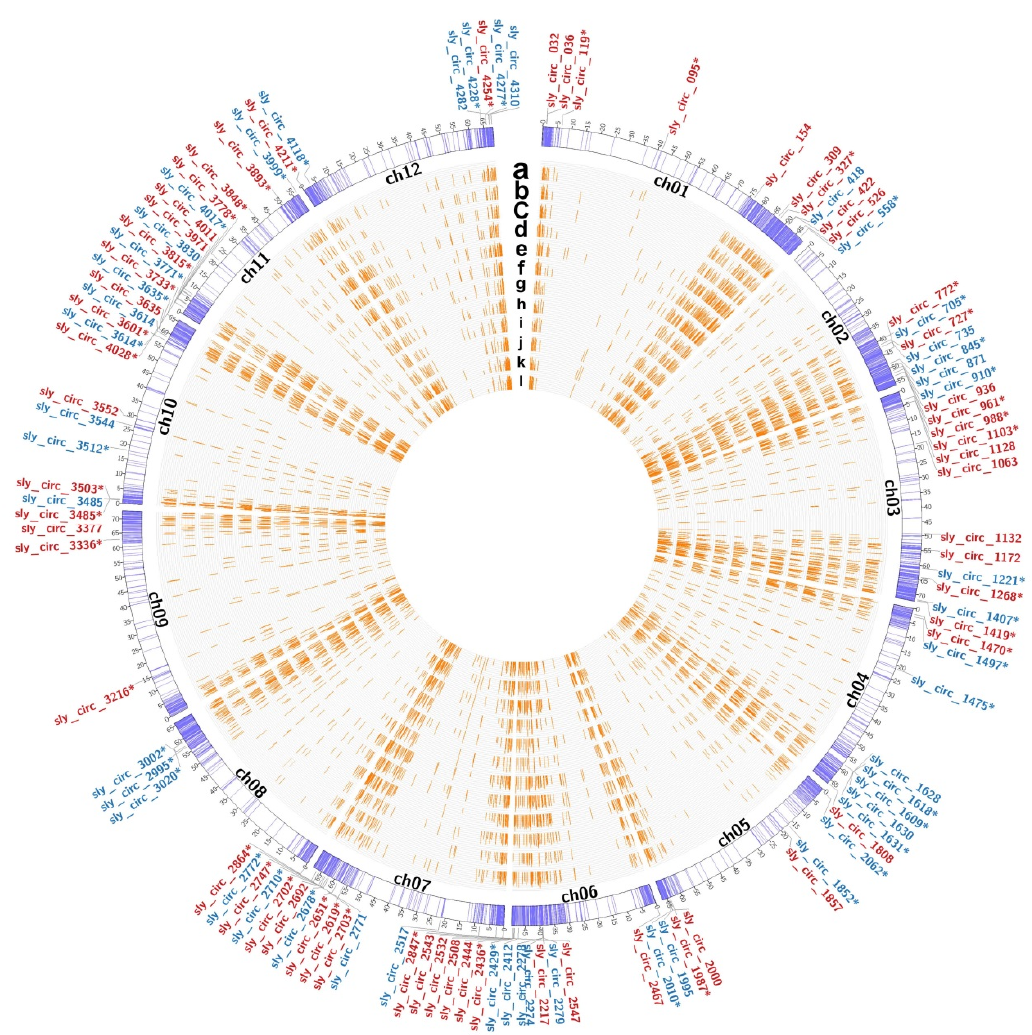
Figure 5. The circos plot of circRNAs shows the distribution of circRNAs in different chromosomes. From outside to inside, the circos plot is divided into three parts. The outermost circle contains the up-regulated (red) and down-regulated (blue) circRNAs. The names of circRNAs with or without asterisks indicate that the circRNAs were from M82 or Solanum pennellii ( S. pennellii ), respectively. The middle circle represents the 12 chromosomes of the tomato, and the purple lines represent the locations of the circRNAs identified in this study. The innermost part represents the expression levels of all circRNAs in each sample. From a to l, the 12 samples M82-CK1, M82-CK2, M82-CK3, M82-T1, M82-T2, M82-T3, P-CK1, P-CK2, P-CK3, P-T1, P-T2, and P-T3 are represented sequentially.